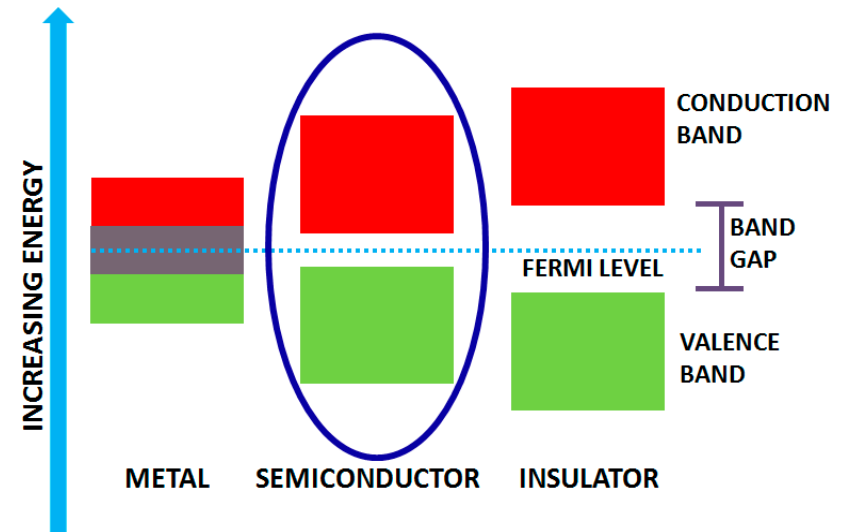
Figure 2. Band gap structure for metals, semiconductors and insulators.